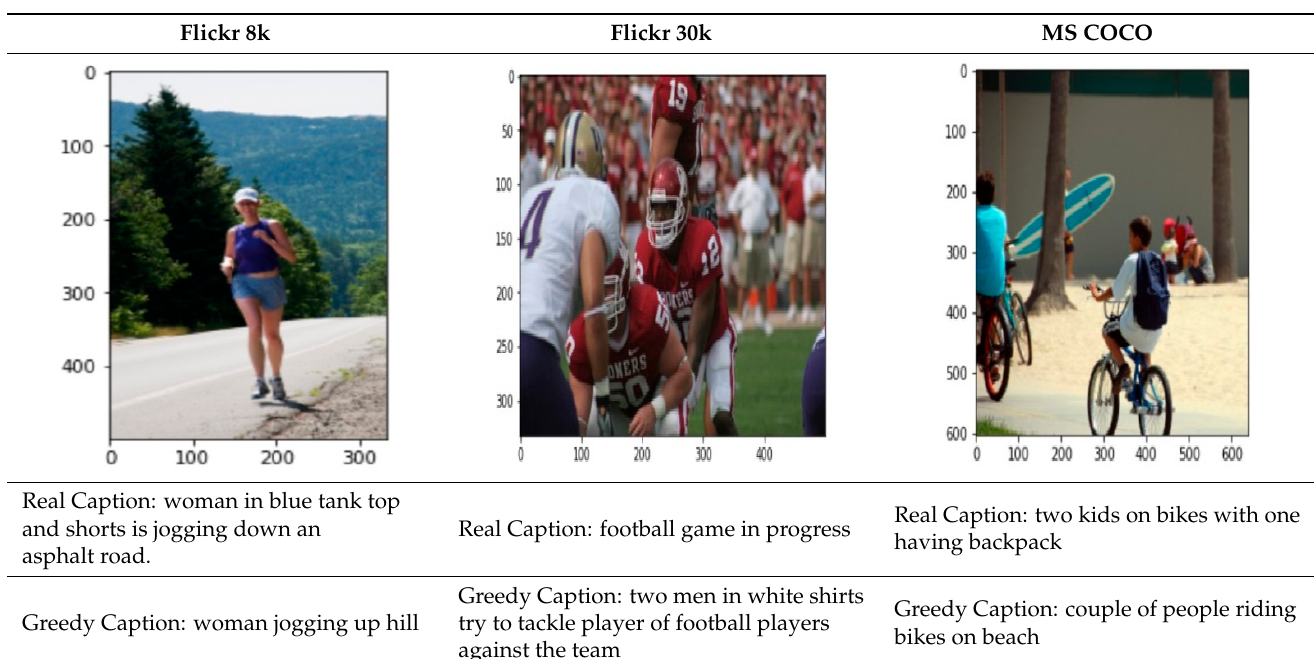
Table 2. A comparison of captions generated from greedy search and beam search on Flickr 8k, Flickr 30k and Microsoft Common Objects in Context (MS COCO) datasets.